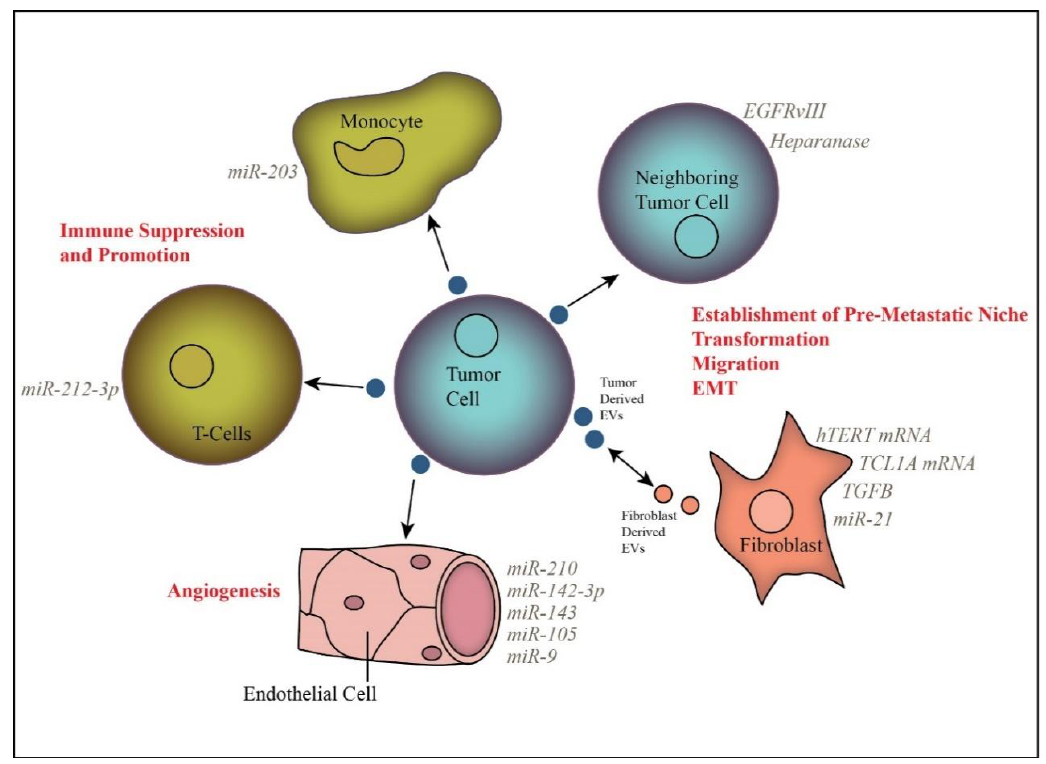
Figure 1. Extracellular vesicle-mediated transfer of specific cargo molecules alters the phenotype of recipient cells, including neighboring tumor cells, fibroblasts, endothelial cells, and immune cells.